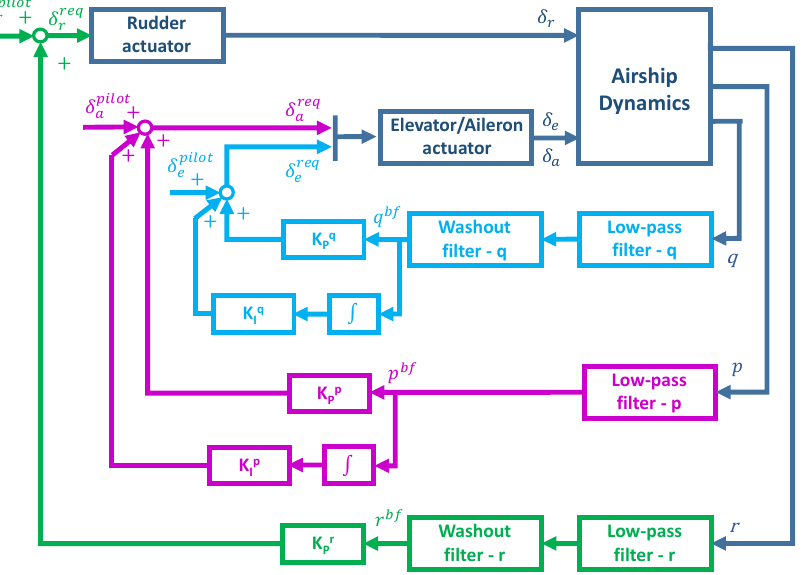
Figure 2. Proposed stabilization control for an airship with deflectable tail control surfaces. Cyan: pitch-rate damper. Purple: roll-rate damper. Green: yaw-rate